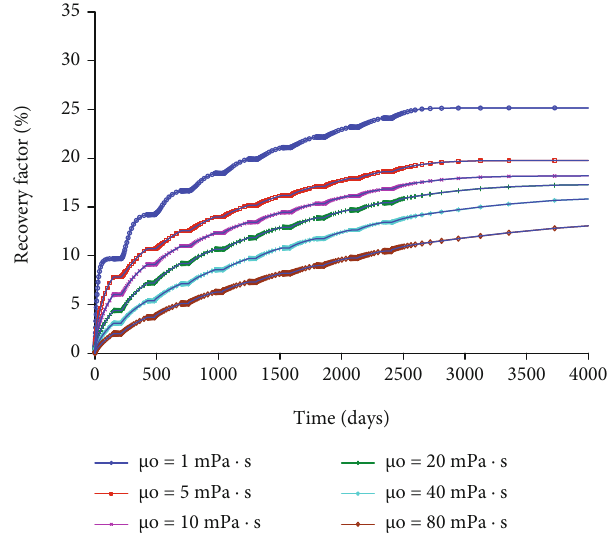
Figure 3: Production curves of reservoirs with di ff erent oil viscosities by cyclic surfactant injection.